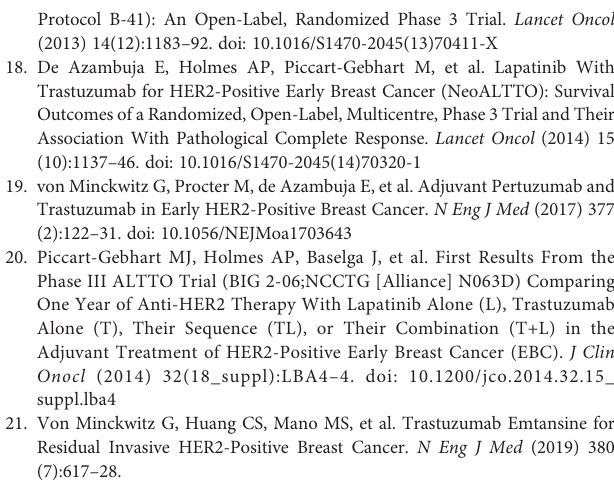
Protocol B-41): An Open-Label, Randomized Phase 3 Trial. Lancet Oncol (2013) 14(12):1183 – 92. doi: